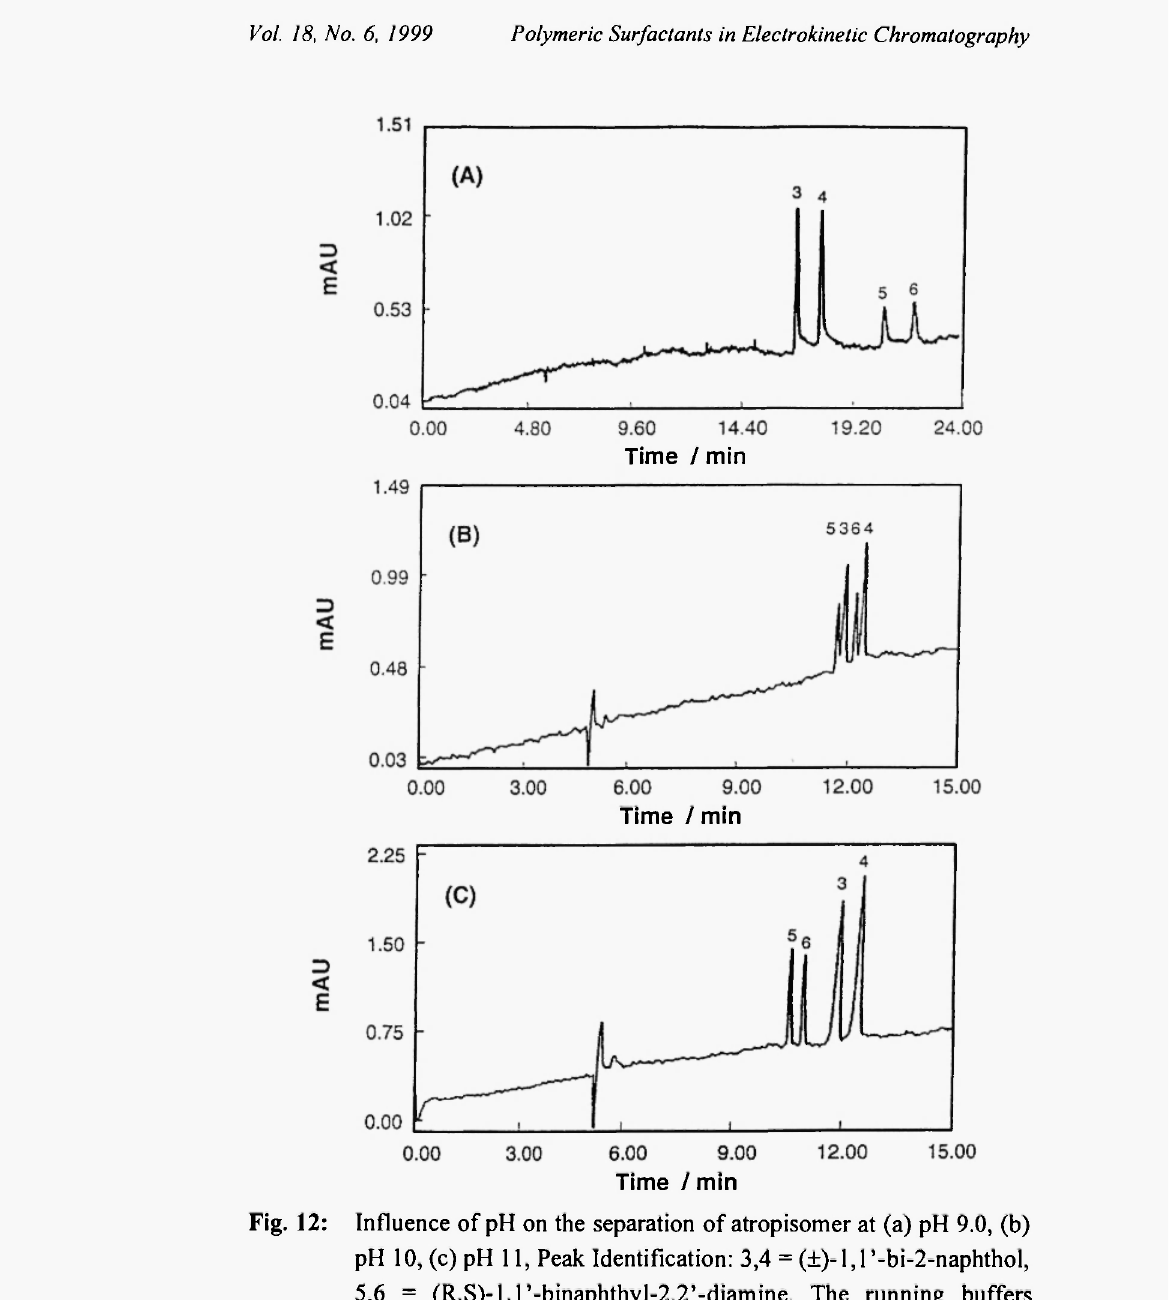
Fig. 12: Influence of pH on the separation of atropisomer at (a) pH 9.0, (b) pH 10, (c) pH 11, Peak Identification: 3,4 = (±)-l,l'-bi-2-naphthol, 5,6 = (R,S)-l,r-binaphthyl-2,2'-diamine. The running buffers composed of 0.25 % w/v of Poly-L-SUV with 25 raM dibasic phosphate: capillary 50 mm χ 60 cm (55.5 cm effective length); applied voltage, + 20 kV, detection 280 nm. From /54/ with